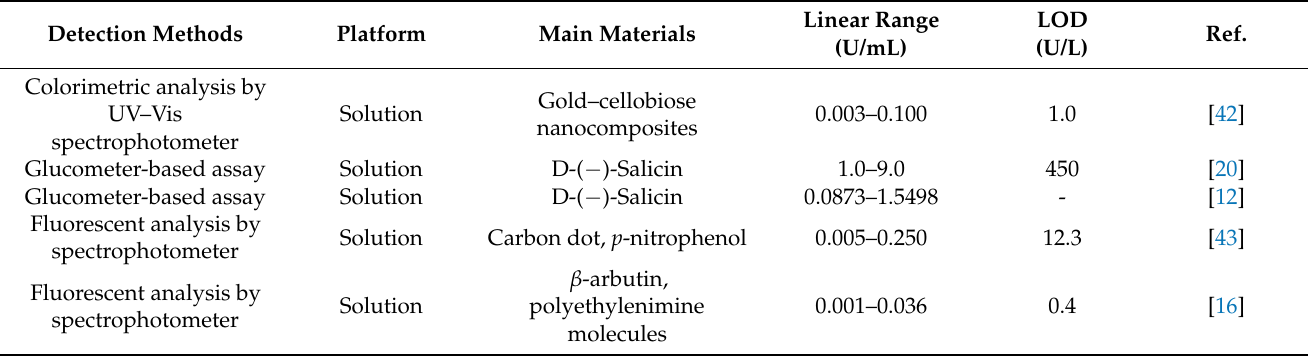
Table 1. Comparison of detection methods for β‐ glucosidase.